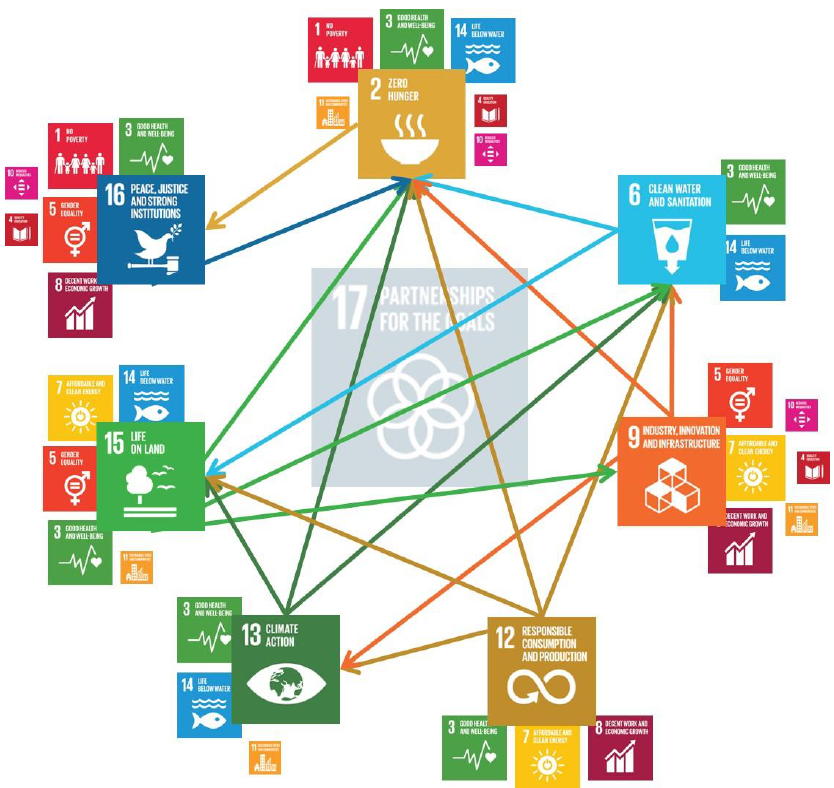
Figure 2. Links between sustainable development goals in the “edible insects’